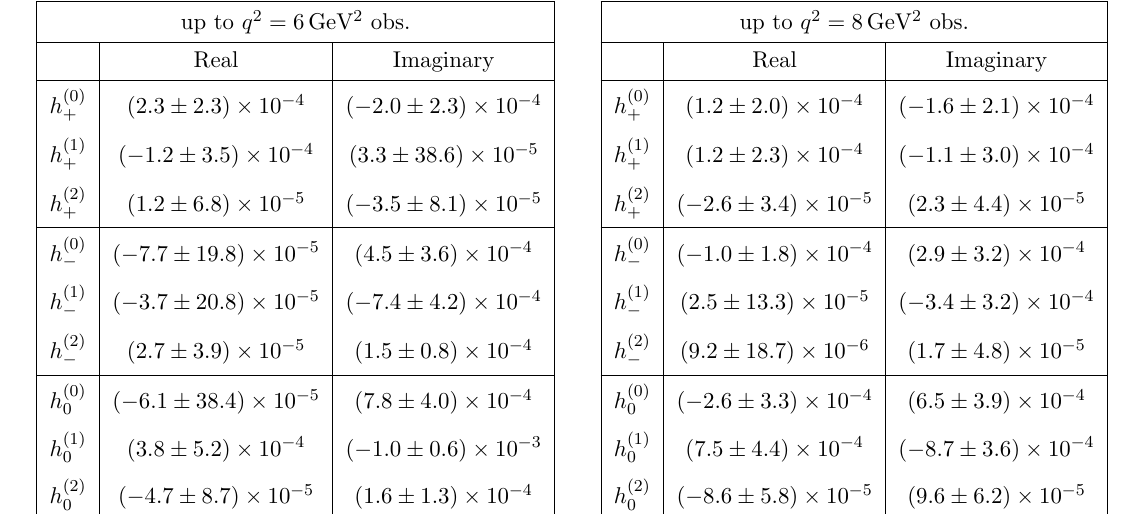
Table 3 . Fit parameters for the power corrections assuming no constraint for h (0 ; 1 ; 2)